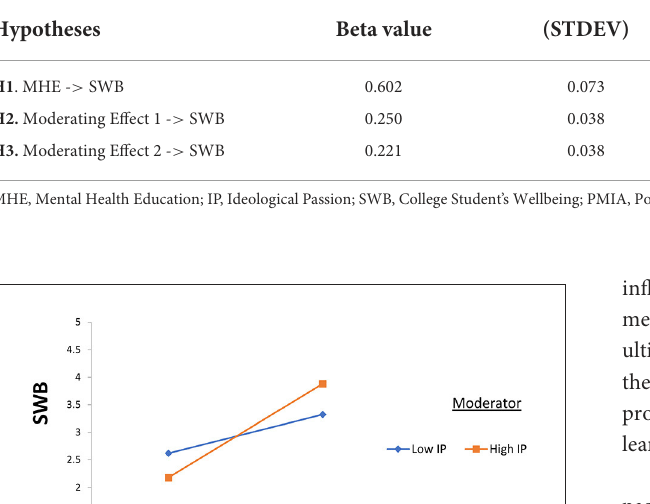
TABLE 3 Hypotheses test.